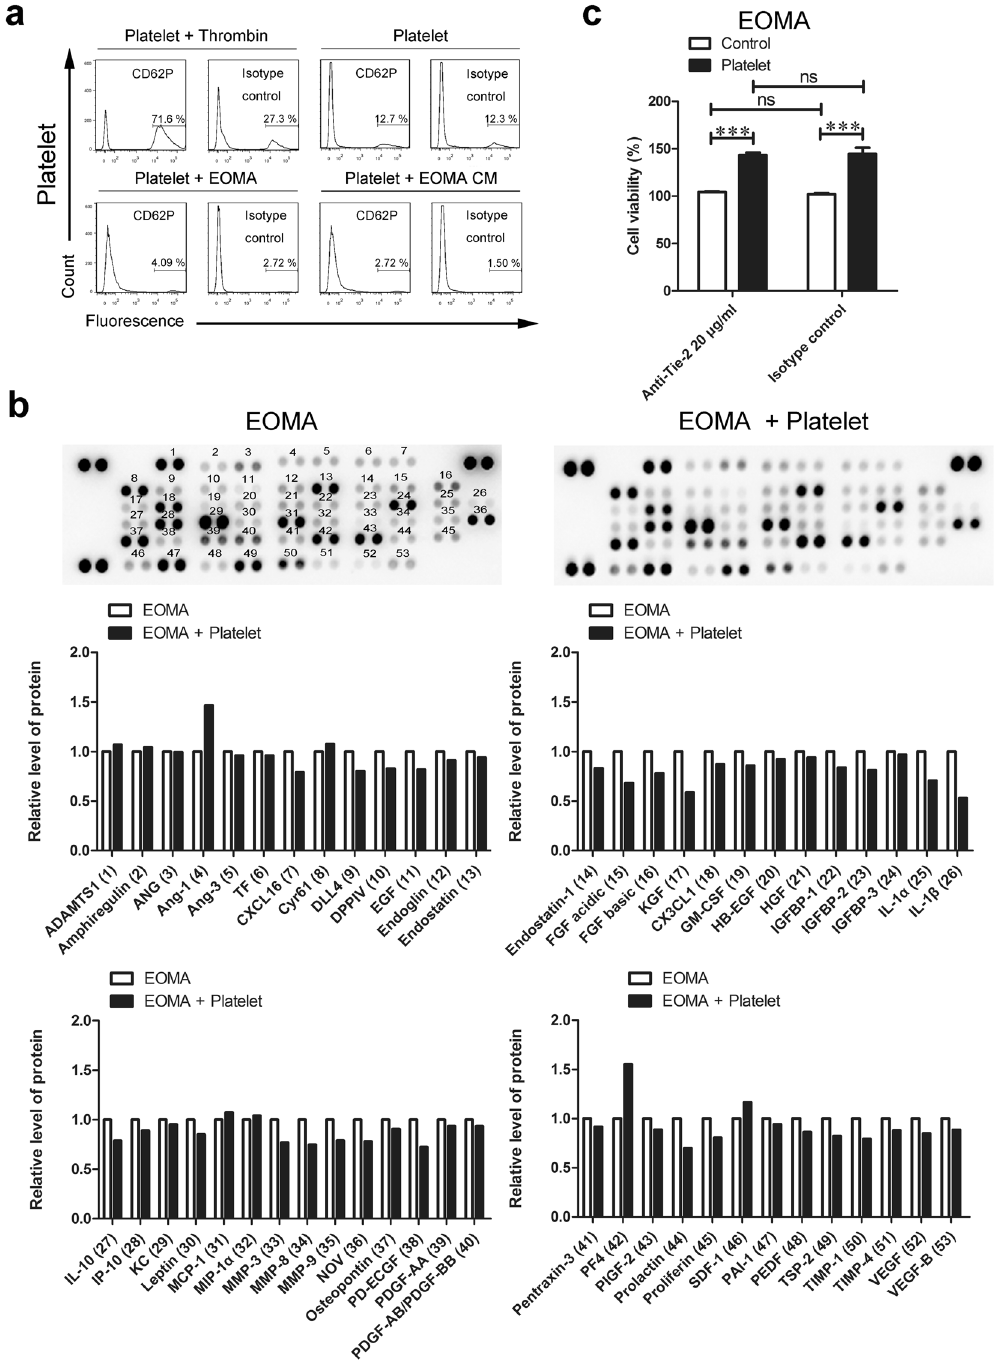
Figure 3. EOMA-platelet co-culture did not stimulate pro-angiogenic activation of platelets. ( a ) Platelets were co-cultured with either EOMA cells or MBMECs, or incubated in conditioned medium (CM) from either EOMA cells or MBMECs for 24 hours. Activation of platelets was then assessed by measuring the surface level of CD62P via flow cytometry. Thrombin was used as a positive control. ( b ) EOMA cells and MBMECs were cultured alone or with platelets for 24 hours. The levels of angiogenic factors in the culture medium were examined using the mouse angiogenesis antibody array. ( c ) EOMA cells were pre-treated with anti-Tie-2 antibody for 30 minutes and then incubated with platelets for another 72 hours. The cell viability was examined by CCK8 assay. n = 4, two-way ANOVA. *** P < 0.001; ns, not